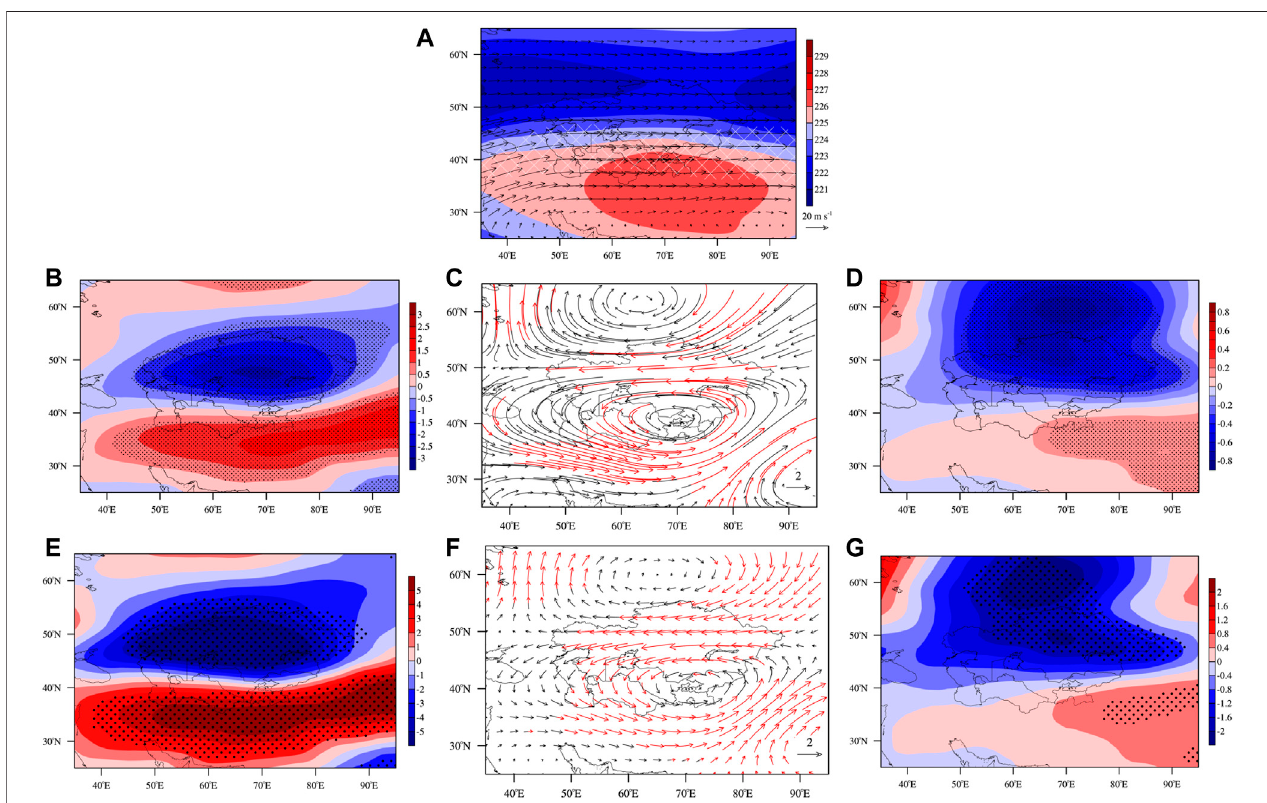
FIGURE4 | (A) Multiyear averaged 200 hPa summer wind fi eld (vectors,unit: m s − 1 ) and temperature (shaded areas, unit: K). (B – D) are the differences in200 hPa zonal wind, wind fi eld,and temperature betweenthe maximum and minimum TPmonsoon index years, respectively, (E – G) aretheregression coef fi cient distributionsof the TP monsoon index for 200 hPa zonal wind, wind fi eld, and temperature fi eld, respectively. The white shaded area in (A) is the area where the zonal wind is greater than 25 m s − 1 . Dotted area in (B,D,E,G) and red wind fi eld in (C,F) is the area that passed the 90% con fi dence level student ’ s t-test.